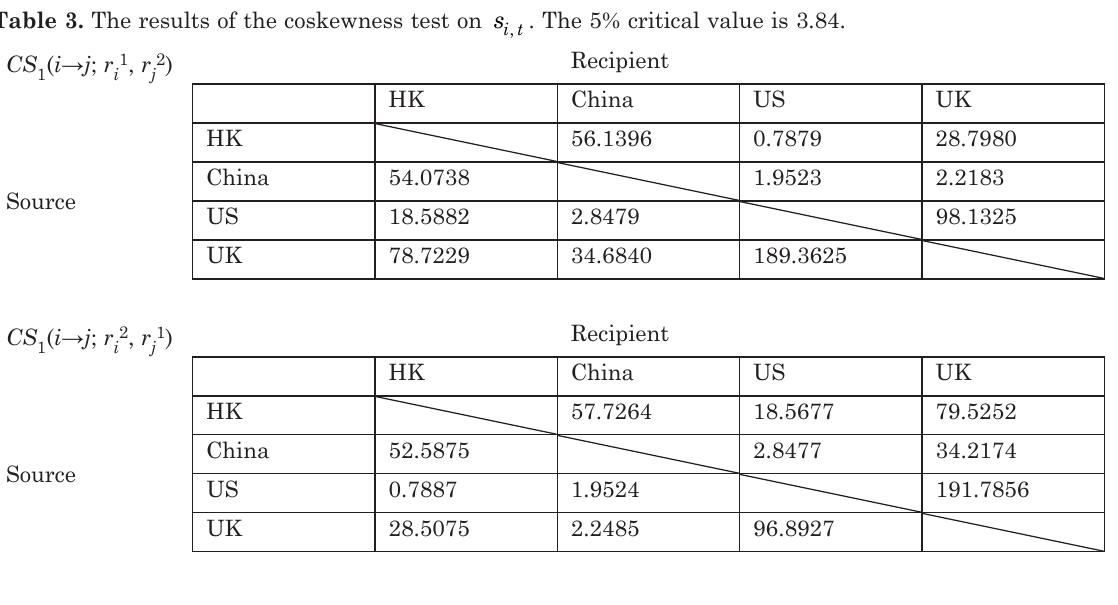
table 2. the results of the forbes-rigobon test on